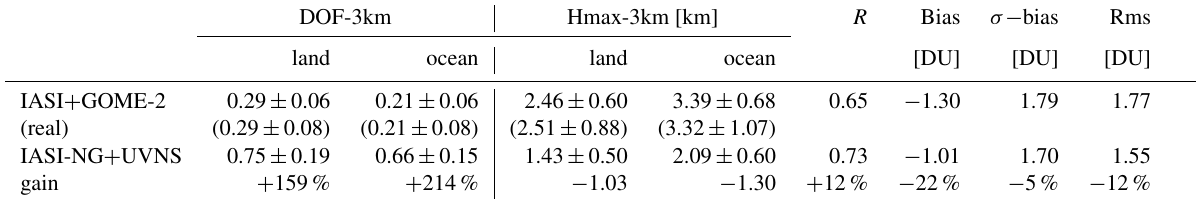
Table 2. Averaged values (8–11 July 2010) of regional mean degree of freedom in the LMT (DOF-3km), altitude of maximum sensitivity in the LMT (Hmax-3km [km]), linear correlation coefficient between PR and PO of O3-3km, together with the mean value (bias [DU]), the standard deviation ( σ -bias [DU]) and the root mean square (rms [DU]) of PO–PR distribution of O3-3km over Europe, from IASI + GOME-2 and IASI-NG + UVNS. Real IASI + GOME-2 values of DOF-3km and Hmax-3km are reported in parenthesis below pseudo-real